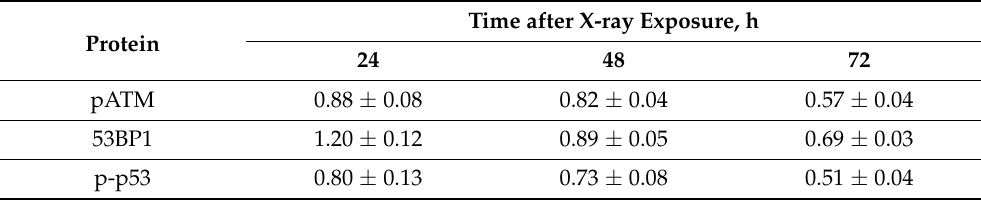
Table A2. The yield of pATM, 53BP1 and p-p53 foci colocalized with γ H2AX foci per unit of absorbed